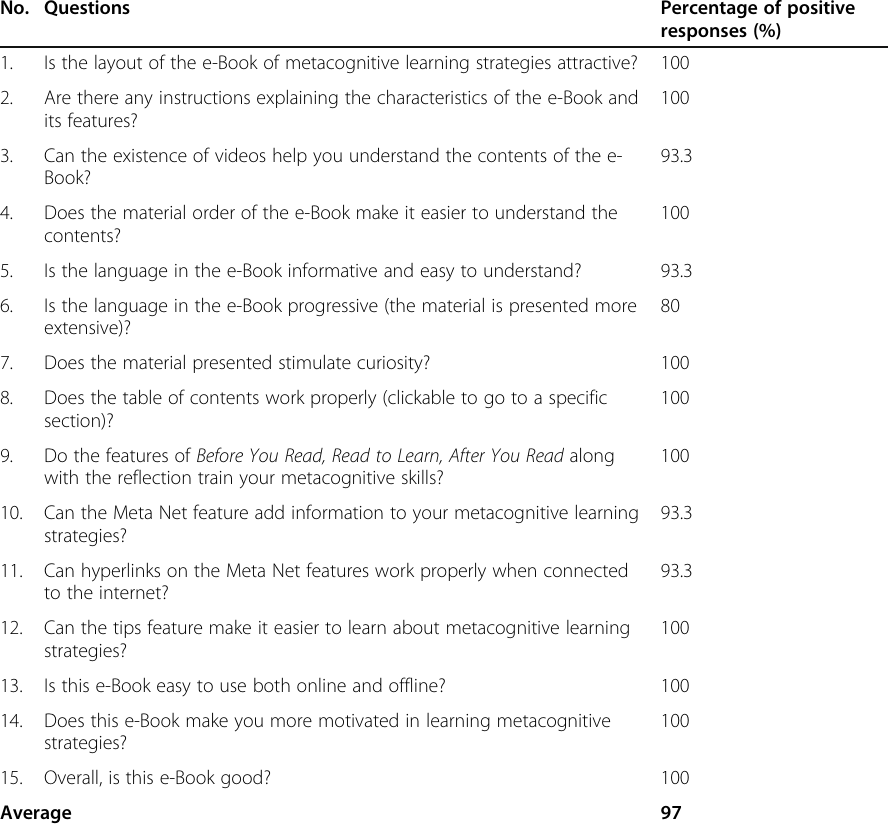
Table 3 The results of the student ’ s responses on the use of e-Book of metacognitive learning